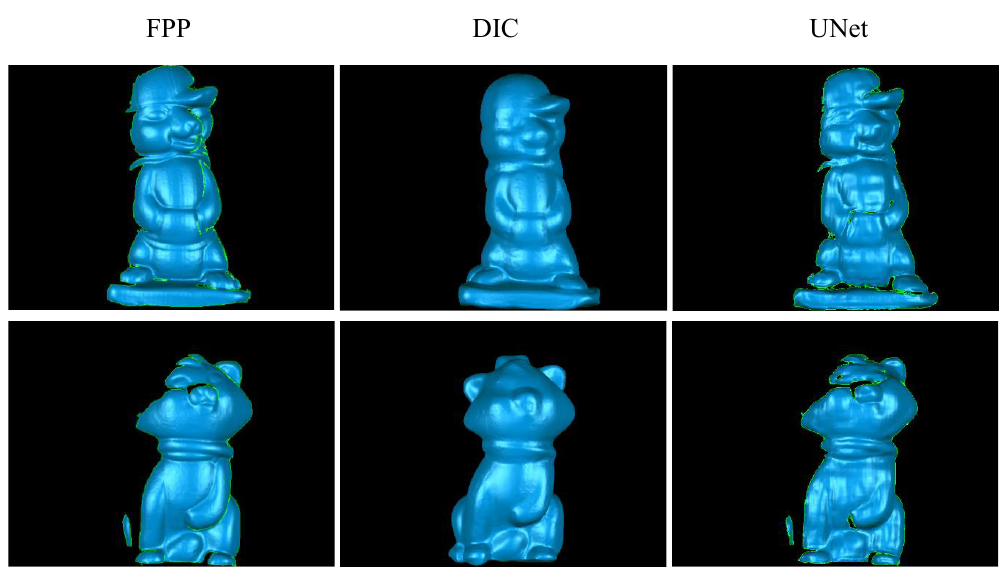
Figure 7. Examples of the 3D shape reconstruction results acquired by using the FPP, the 3D-DIC, and the proposed UNet